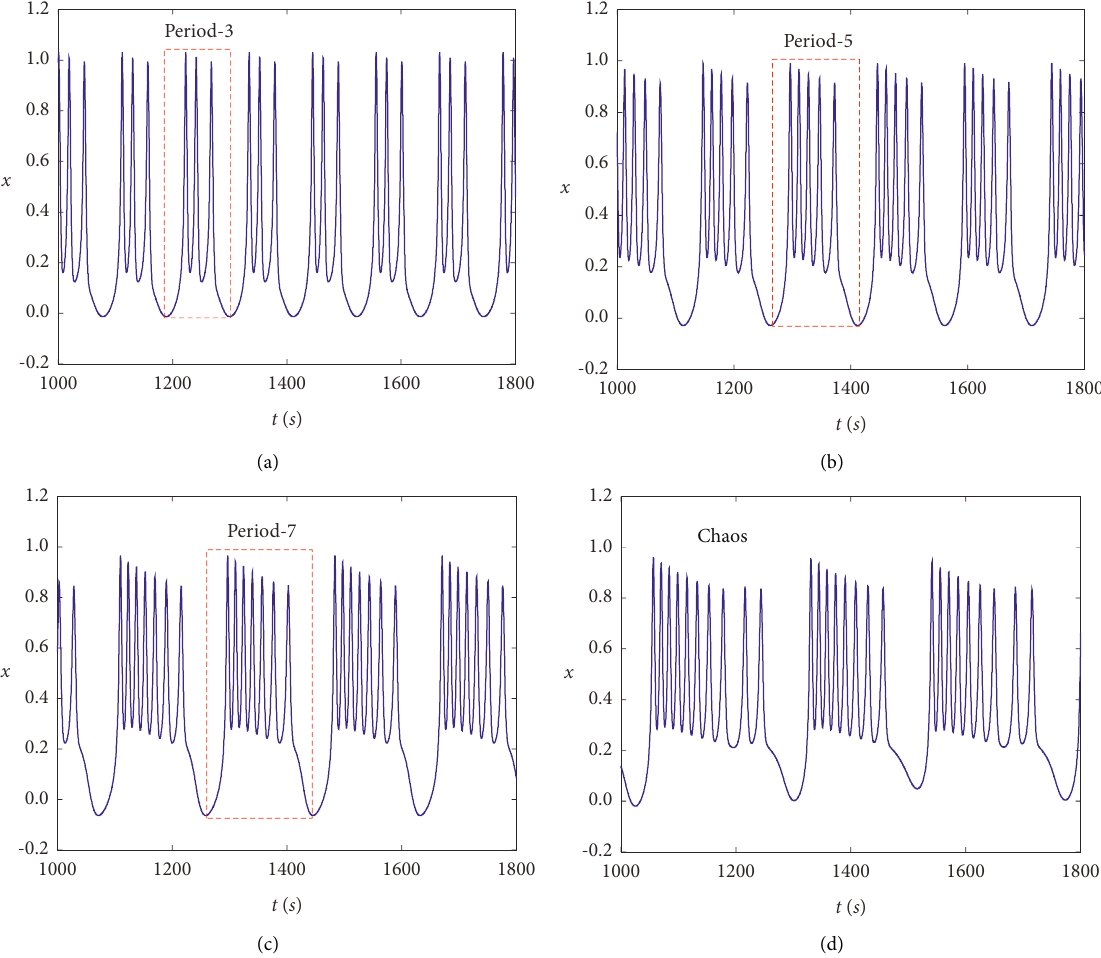
Figure 4: The time response diagrams for different parameters s and b ) � (− 1 . 588 , − 0 . 051 ) , and (d) ( s,b (c) ( s,b 1